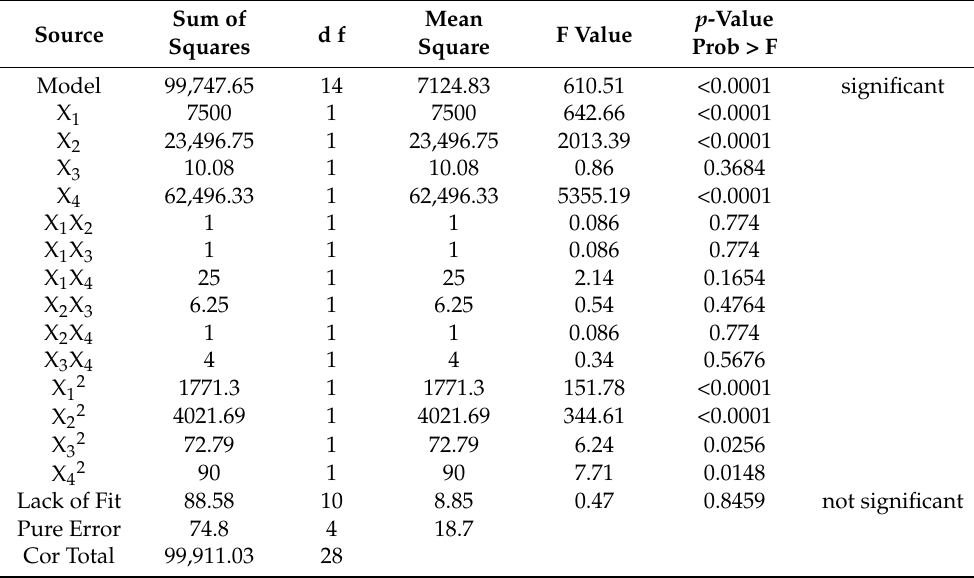
Figure 3. Single-factor optimization of the absorption process of (ViIm)2C6(L-Pro)2 to EGCG. ( a ): pH of the adsorption solution; ( b ): adsorption temperature; ( c ): adsorption time and ( d ): the solid–liquid ratio in the adsorption process. Table 1. Results of the variance analysis from the response surface